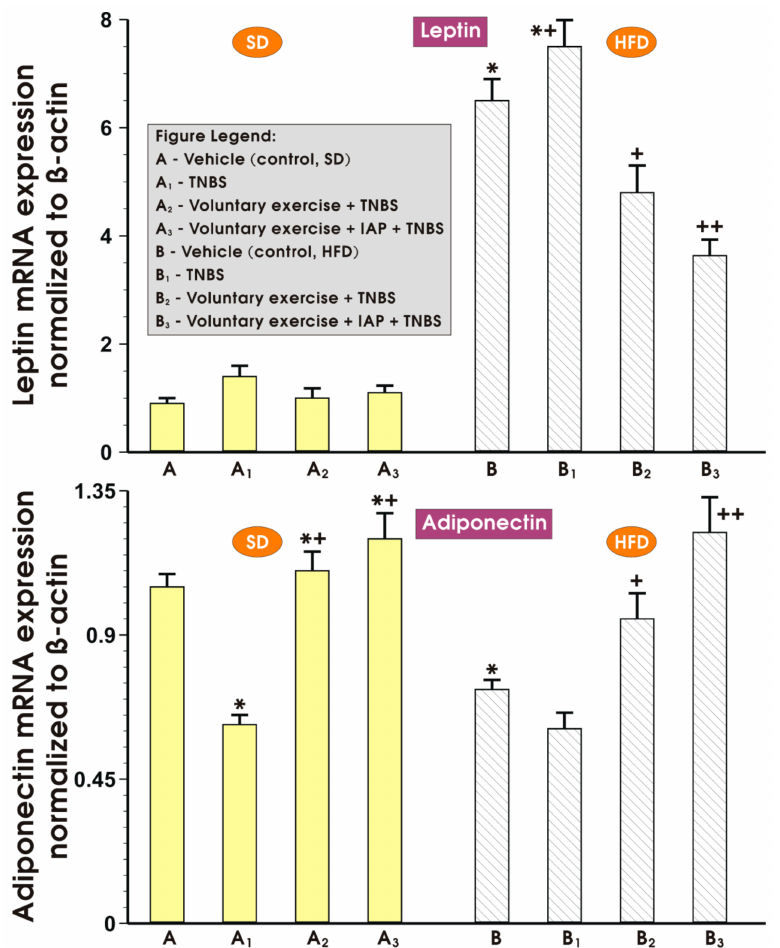
Figure 6. The changes in mRNA expression of leptin (upper panel) and adiponectin (lower panel) determined in the mesenteric fat of sedentary mice with or without TNBS colitis fed an SD or HFD and subjected or not subjected to voluntary exercise with or without treatment with IAP. Results are mean ± S.E.M. of eight animals per experimental group, * significantly different ( p < 0.05) from the sedentary mice fed an SD, * + significantly different ( p < 0.05) from the animals with colitis fed SD or HFD, + significantly different ( p < 0.05) from the sedentary mice fed an SD, ++ significantly different ( p < 0.05) from mice fed HDF subjected to moderate exercise without IAP